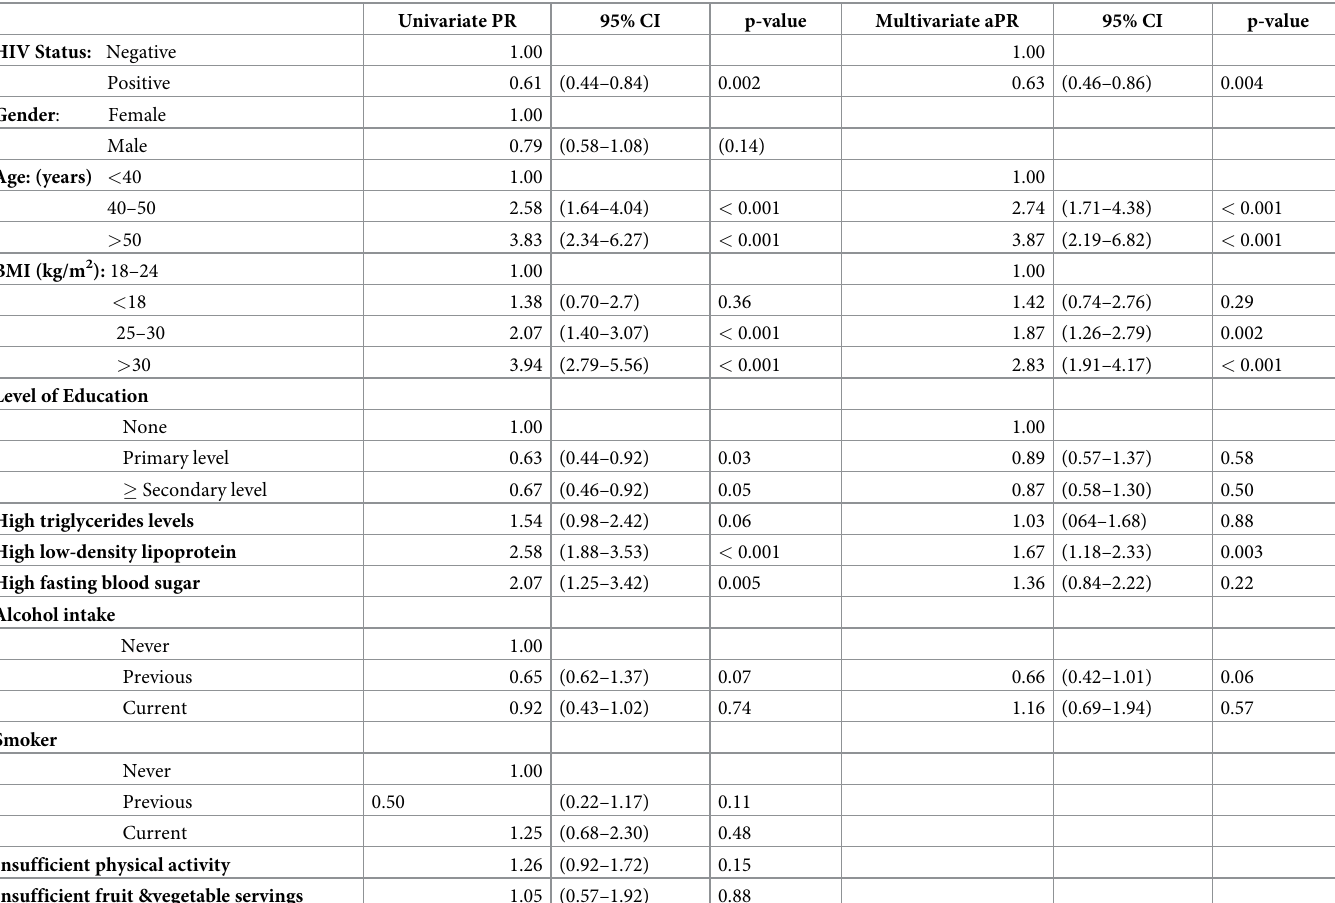
Table 3. Univariate and multivariate associations between risk factors and hypertension 1